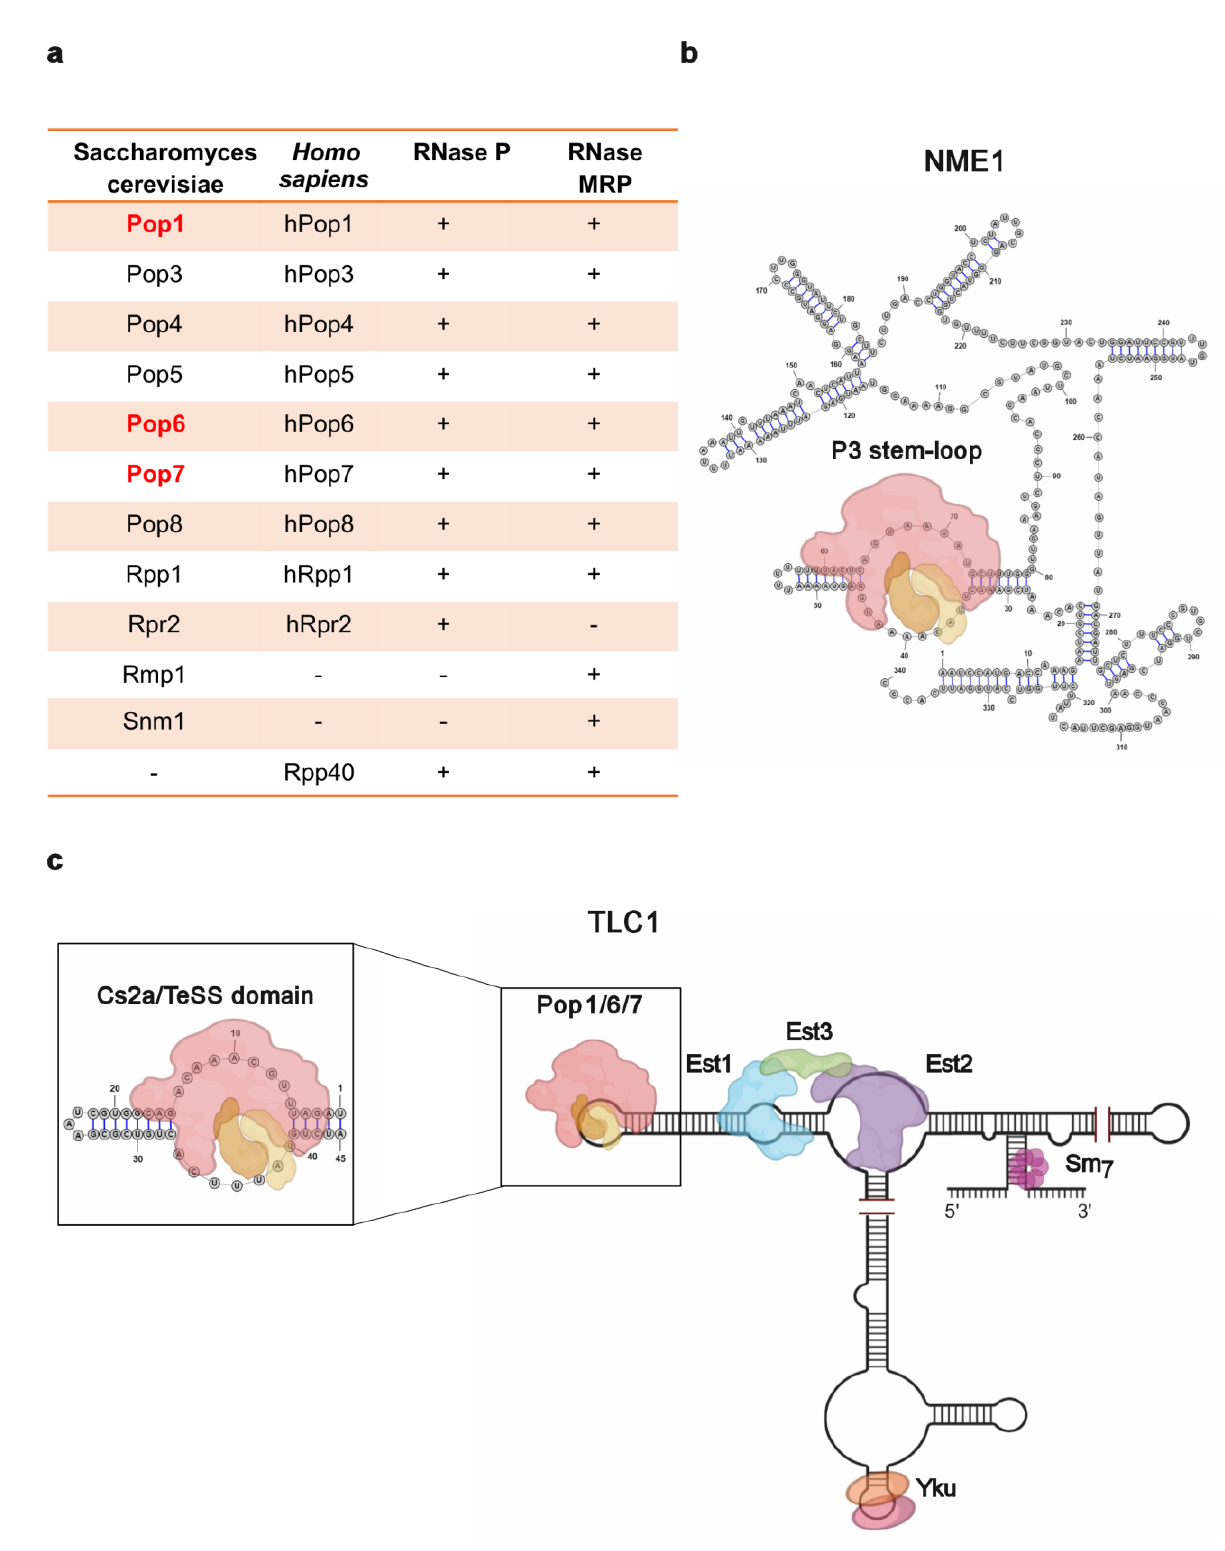
FIGURE 1. (a) Table presents names of proteins in RNase P and MRP in both S. cerevisiae and H. sapiens; (+) and (-) indicate presence or ab- sence of the protein in the indicated RNase complex. Names of three Pop proteins that are telomerase-associated in S. cerevisiae are in red . (b) Structure of the 340 nt RNase MRP RNA subunit, NME, bound by Pop1 (red; ~100kDa), Pop6 (orange; ~18 kDa), Pop7 (tan; ~16 kDa) at the P3 stem-loop domain. (c) Diagram of the 1157 nt S. cerevisiae telomerase RNA, TLC1, bound by the core holoenzyme protein components. Expanded area depicts the Cs2a/TeSS (P3-like) domain in TLC1 to which Pop1, 6, and 7 bind. Images were made in BioRender (bioren-